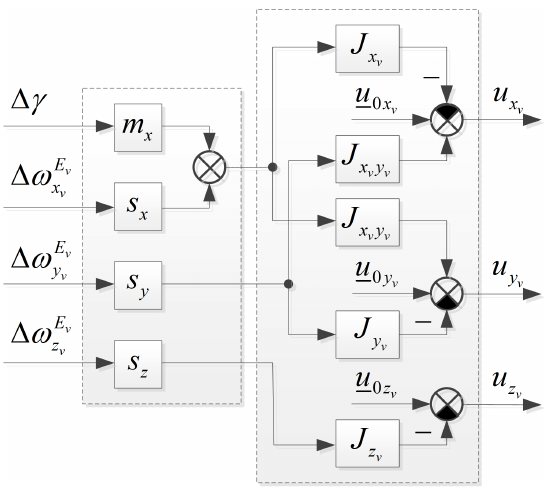
Figure 2. Robust control formation